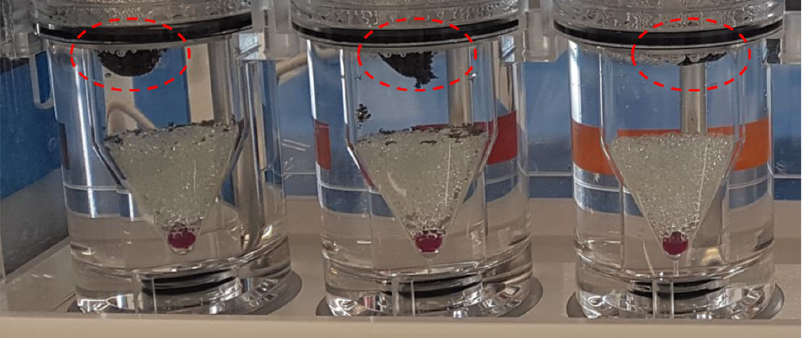
Table 2. Mean apparent density of formulations obtained by SLS ( n = 10) and results of buoyancy observations in Apparatus 4.